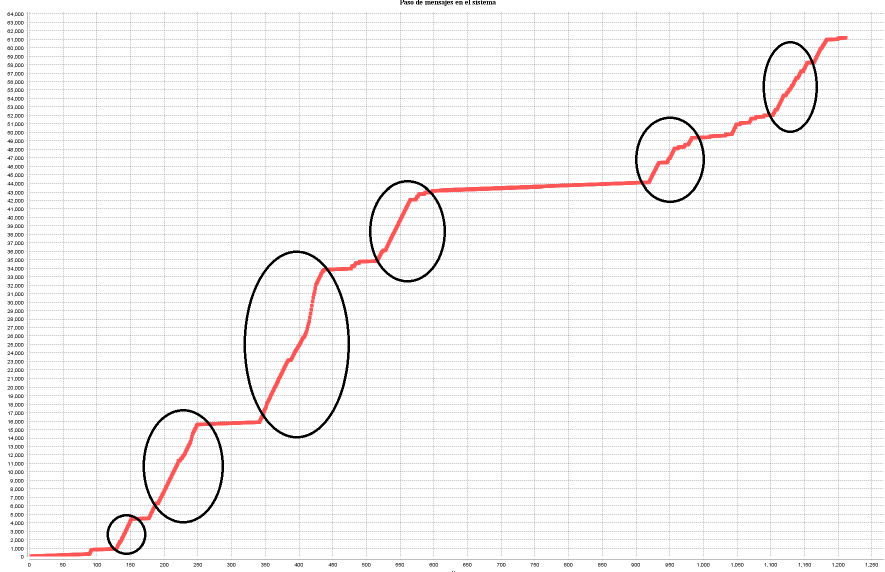
Figure 7. Passing of messages within the